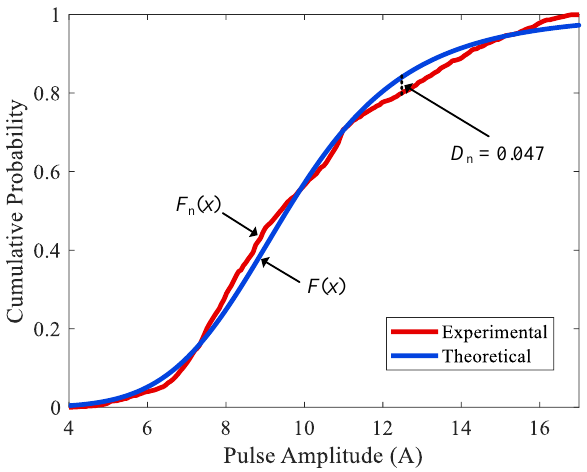
Figure 6. Experimental and theoretical cumulative distribution of A + .